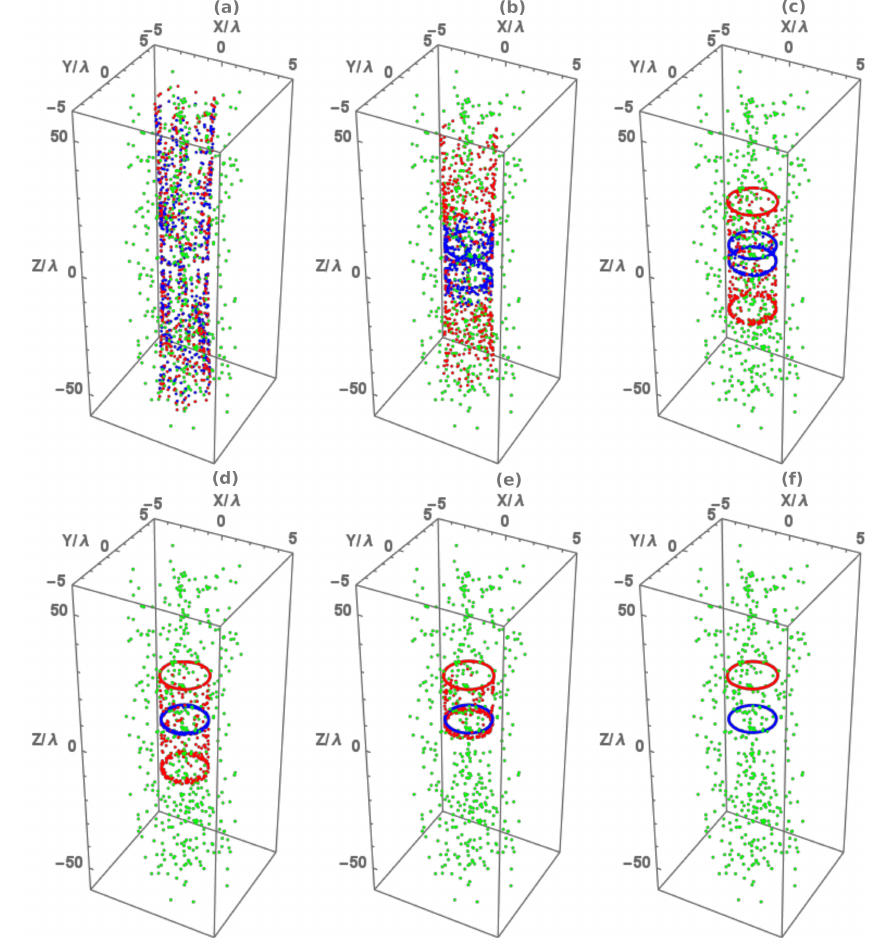
Figure 4. Particles’ position at different times: ( a ) t = 0.01 s, ( b ) τ = 0.1 s, ( c ) t = 1 s, ( d ) t = 2 s, ( e ) t = 5 s, and ( f ) t = 10 s, for τ = 10 Hz ( δ > 0 blue and δ < 0 red; green dots show the initial particles’